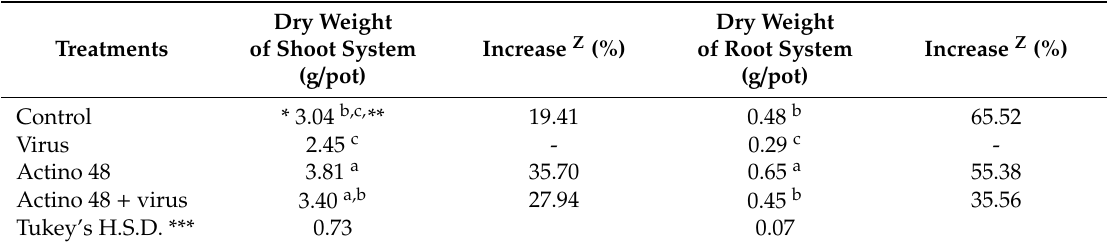
Table 4. Effect of treatment with cell pellet suspension of Streptomyces cellulosae Actino 48 on dry weight of shoot and root systems in tomato plants inoculated with tobacco mosaic virus.